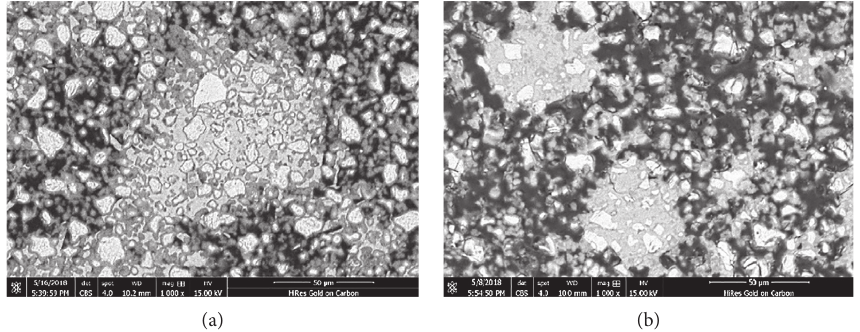
Figure 10: BSE image of the surface layer of the mineralization group (a) and carbonization group (b) (0 ∼ 1 ± 0.3 mm).